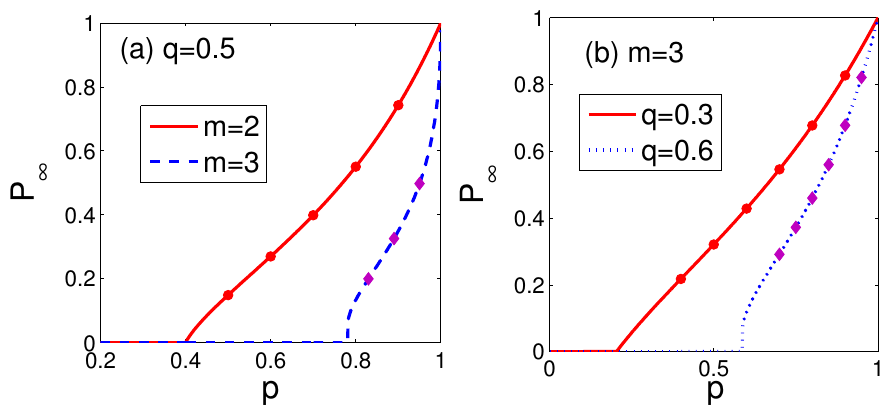
Figure 4. The giant component for an RR network composed of ER networks, P function of p , for ER networks with average degree (cid:104) k (cid:105) = 10 , ( a ) for two different values of m and q = 0 . 5 and ( b ) for two different values of q and m = 3 . The curves in (a) and (b) are obtained using Equation (6) and are in excellent agreement with the simulations (symbols). The symbols are obtained from simulations by averaging over 20 realizations for N = 2 × 10 5 . In (a), simulation results are shown as circles ( n = 6 ) for m = 2 and as diamonds ( n = 12 ) for m = 3 . These simulation results support our theoretical result, Equation (6), which is indeed independent of the number of networks n . After